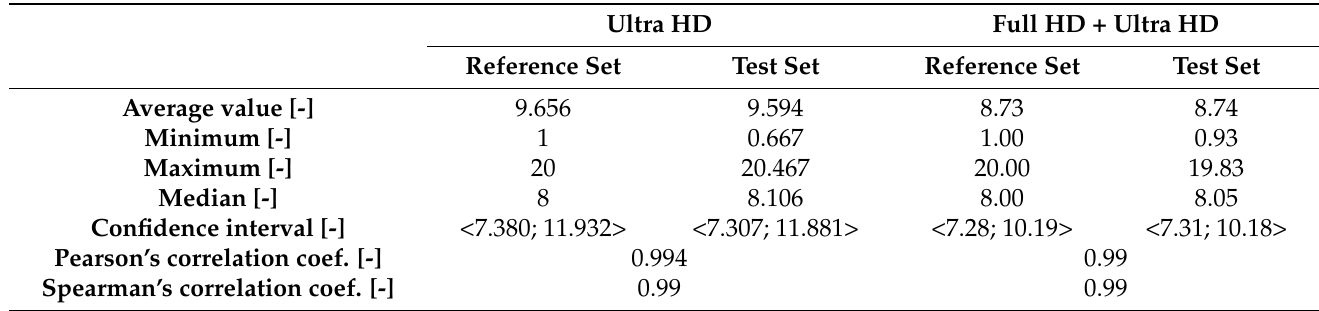
Table 12. Descriptive statistics for bitrate prediction based on MOS, Ultra HD, H.264 +